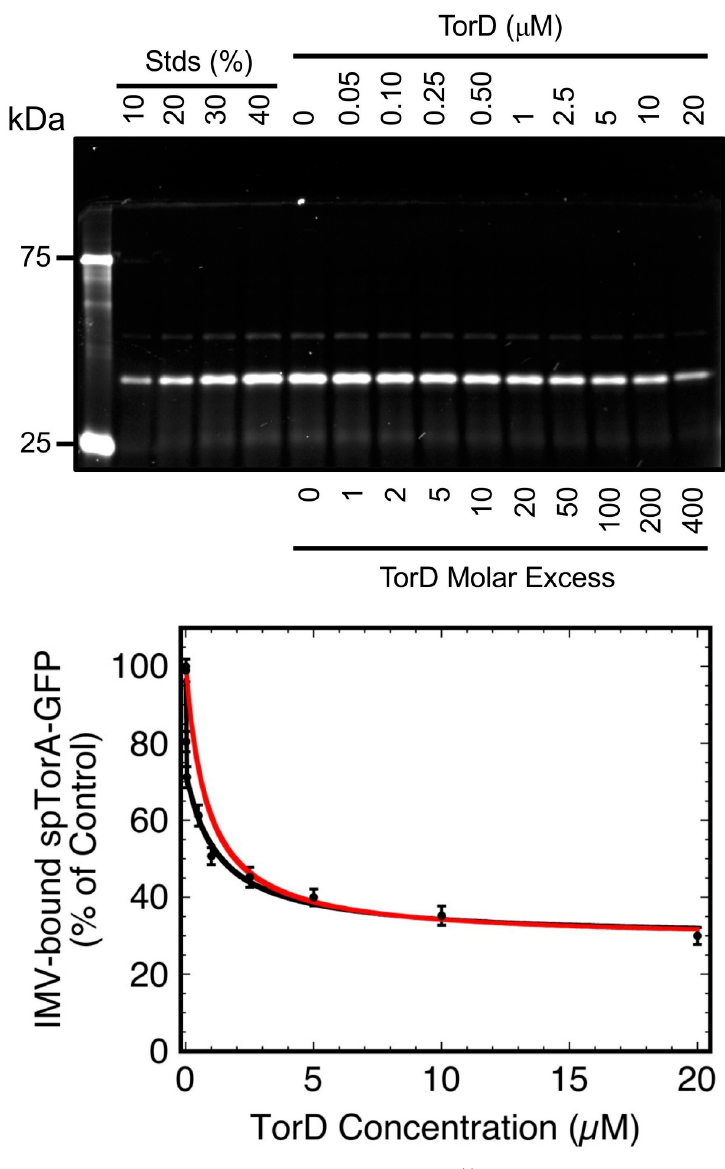
Fig 7. TorD reduces the binding of spTorA-GFP to Tat ++ IMVs. The spTorA-GFP(Alexa532) protein (50 nM) was pre-incubated with various concentrations of TorD (10 min, 37˚C), incubated with Tat ++ IMVs ( A 280 = 5; 10 min at 37˚C), and centrifuged to remove unbound protein (32,000 g , 4˚C for 10 min). The pellets were analyzed by SDS-PAGE, and the amount of IMV-bound spTorA-GFP(Alexa532) was quantified by in-gel fluorescence imaging using the standard lanes for calibration (% of 50 nM). Data are normalized to the 0 μ M TorD sample (100%; N = 3). Assuming that the TorD interaction with spTorA-GFP prevents the precursor from binding to the IMVs, three binding regimes are apparent: first phase (~30%), linear fit; second phase (~40%), single site Langmuir binding isotherm ( K D = 1.3 ± 0.3 μ M) [46]; third phase (~30%), no apparent binding to TorD. The first two phases (independent fits in black ) are also simultaneously fit to a single site binding model that accounts for the precursor concentration, but not the IMV binding sites ( red curve )